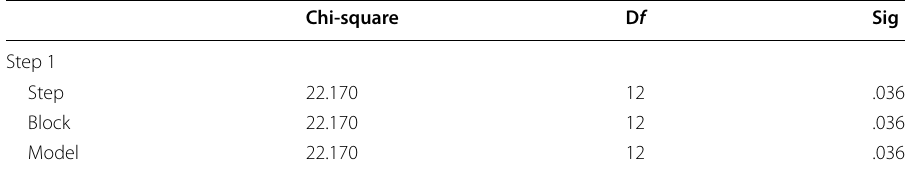
Table 2 Omnibus test of the model coefficient